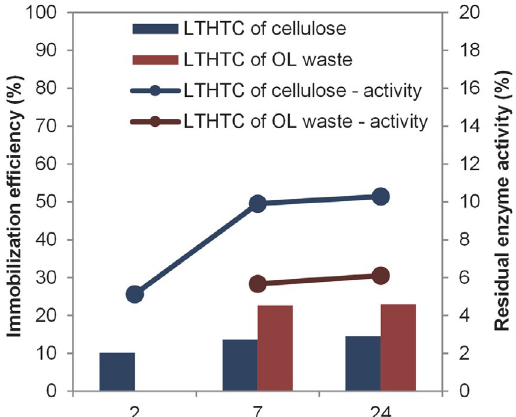
Figure 4. Influence of immobilization time on immobilization effi- ciency and residual enzyme activity. Reaction conditions: 5 mg of chosen biochar, enzyme concentration of 2.3 mg/mL, crosslinker PEHA, PBS with pH 7, ambient temperature and atm. pressure. Standard deviation for all measurements was less than ± 3%.